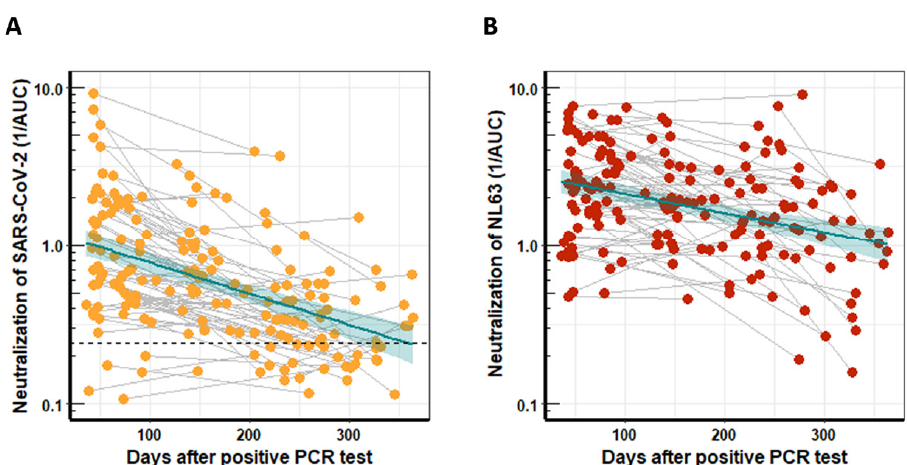
Figure 1. Neutralization activity of longitudinal serum samples from COVID-19 patients. The neutralization activity was determined with pseudotyped lentiviral vectors and calculated using the reciprocal areas under the curve (1/AUC). ( A ) SARS-CoV-2 WT neutralization activity of serum from 80 COVID-19 patients who had provided two blood donations, plotted against time after PCR-confirmed COVID-19 infection. The dashed line indicates the mean 1/AUC background values of the assay, which were generated from sera of 12 previously SARS-CoV-2 naïve individuals plus two standard deviations. ( B ) Serum neutralization of NL63 for the same cohort as in ( A ) plotted against time after PCR-confirmed COVID-19 infection. The turquoise line indicates the linear regression trendline, and shaded areas represent the respective standard derivations.